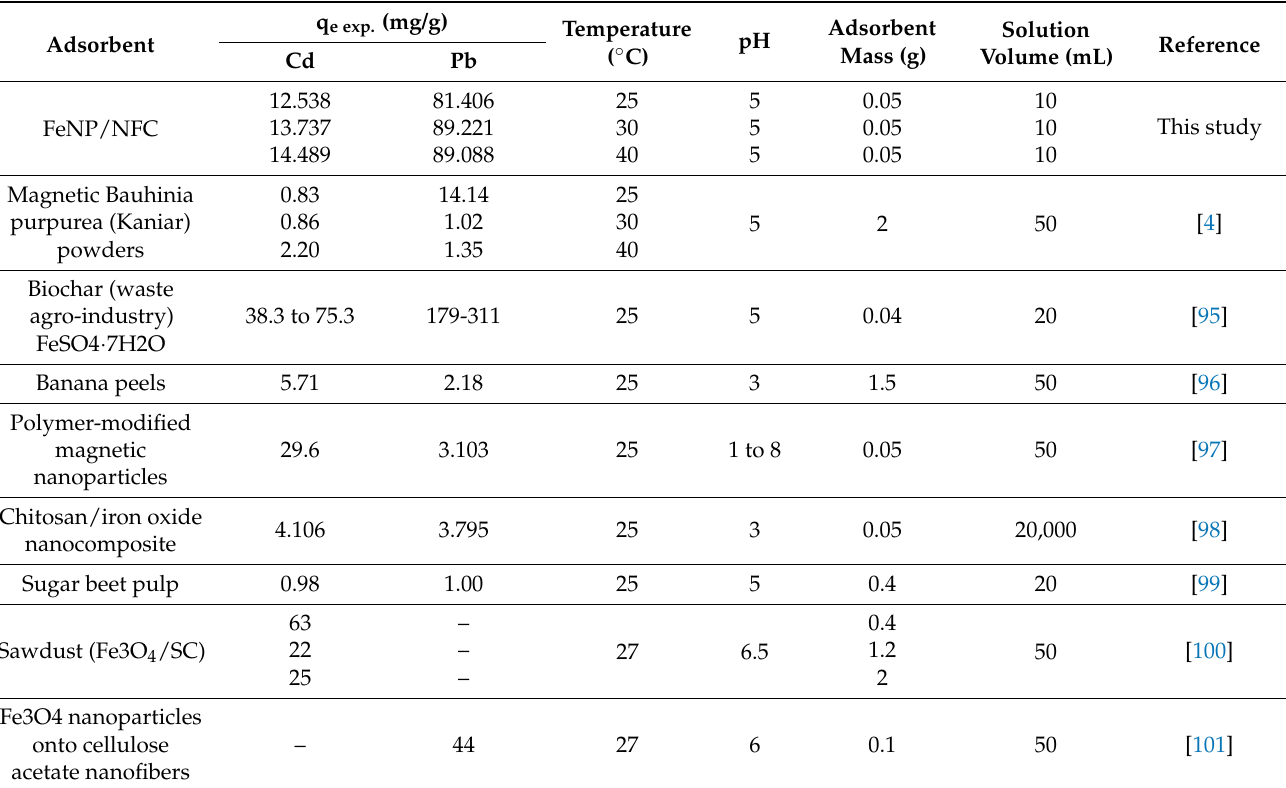
Table 4. Cd and Pb adsorption capacities of different